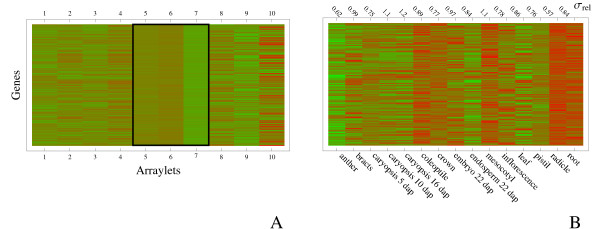
Relation between co-expression within the central arraylets to co-expression in the microarray data. Panel A shows gene expression as measured in the arraylets defined by the GSVD using a set of genes described in the main text (green – low expression, red – high expression). Only the 200 transcripts whose expression profile in the central arraylets 5–7 (boxed) is closest to that of HvCslF3 (as measured by Euclidean distance) are shown. The expression profiles for the same genes, in the space spanned by arrays, are shown in panel B. Approximate co-expression can be seen for some tissues (e.g. expression in anther, caryopsis and endosperm tends to be low, while expression in root, radicle and coloeptile tends to be higher). At the top of panel B we indicate, for each tissue, the standard deviation of expression values among the genes shown on the plot, scaled with the corresponding quantity for the whole dataset; i.e. values larger (smaller) than one indicate larger (smaller) variability than average. As expected (see text), variability in expression is smallest in those tissues represented in both datasets.